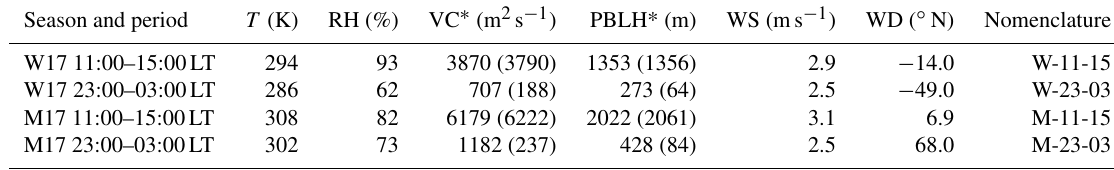
Table 1. Summary of meteorology in the time-of-day PMF periods. Season and